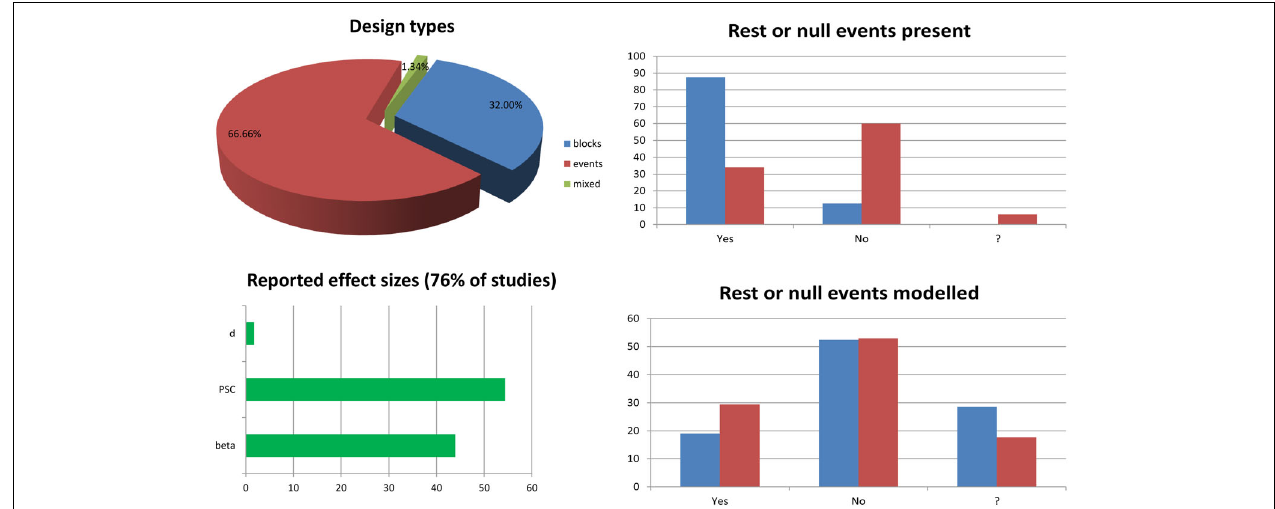
FIGURE 1 | Survey of 6 months of fMRI literature obtained from the journal Neuroimage between January and June, 2013. The list of article reviewed and the information sheet used for the survey are presented in annex 1 . The pie chart splits studies into block design ( n = 24 . 75—blue), event related design ( n = 50 . 75—red), and mixed design ( n = 1 . 75—green) ones. Bar graphs on the top right show the percentages of studies having rest periods or null events among block design vs. event related design